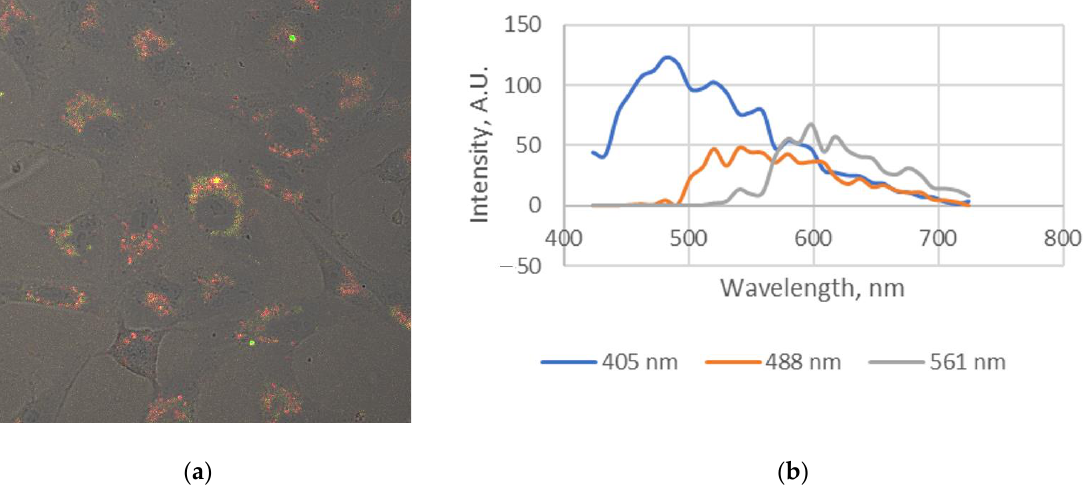
Figure 5. Combined image ( a ) and fluorescence spectra extracted from images ( b ) of Vero cells stained with compound 6a , obtained in transmission mode and in fluorescent lambda mode by a laser excitation with a long wavelength of 561 nm.